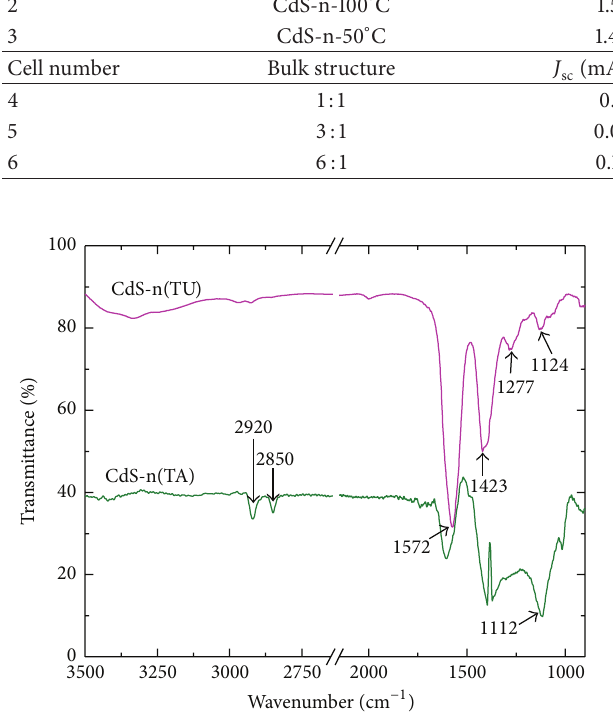
Figure 4: FT-IR spectra of CdS-n(TU) and CdS-n(TA) in KBr pellets, synthesized at 100 ∘ C for 30min.